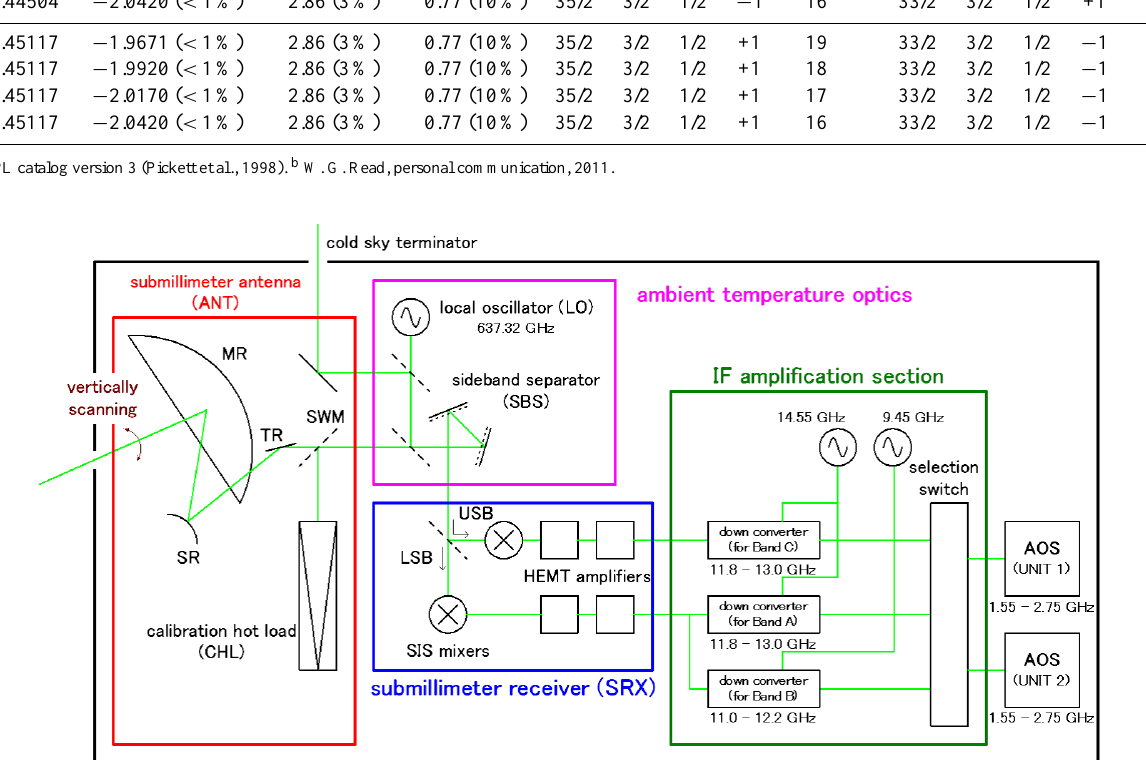
Fig. 2. Schematic of the SMILES payload.